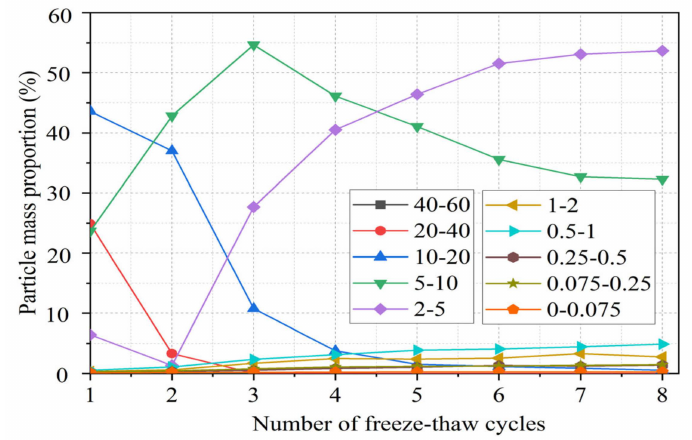
Figure 9. The proportion percentage variation in each particle